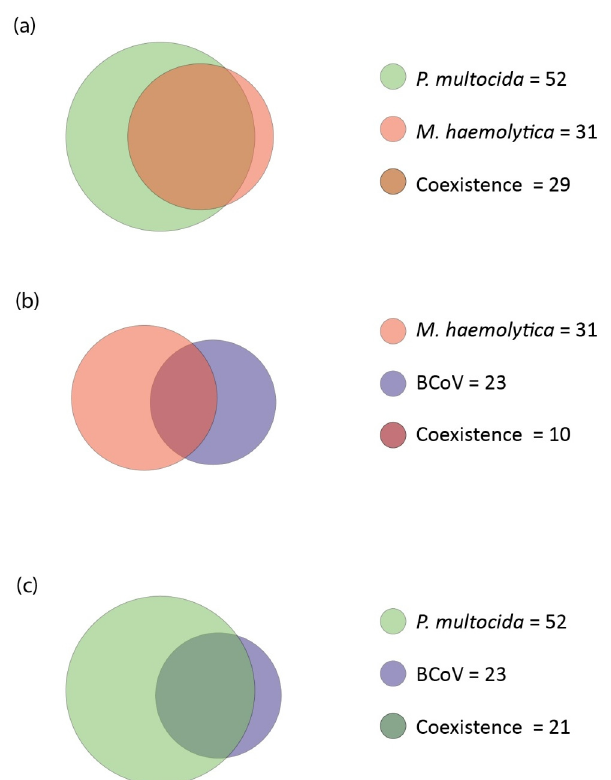
Figure 6. Area-proportional Euler diagrams with coexistence of the three pairs of pathogens with the highest recorded prevalence. The area of the circle corresponds to the number of occurrences of a given pathogen in coinfections. The common part indicates the number of coinfections in which the co-occurrence of both pathogens shown was recorded, regardless of the rest of the pathogens in the coinfection. ( a ) Coexistence of P. multocida and M. haemolytica . ( b ) Coexistence of M. haemolytica and BCoV. ( c ) Coexistence of P. multocida and BCoV.